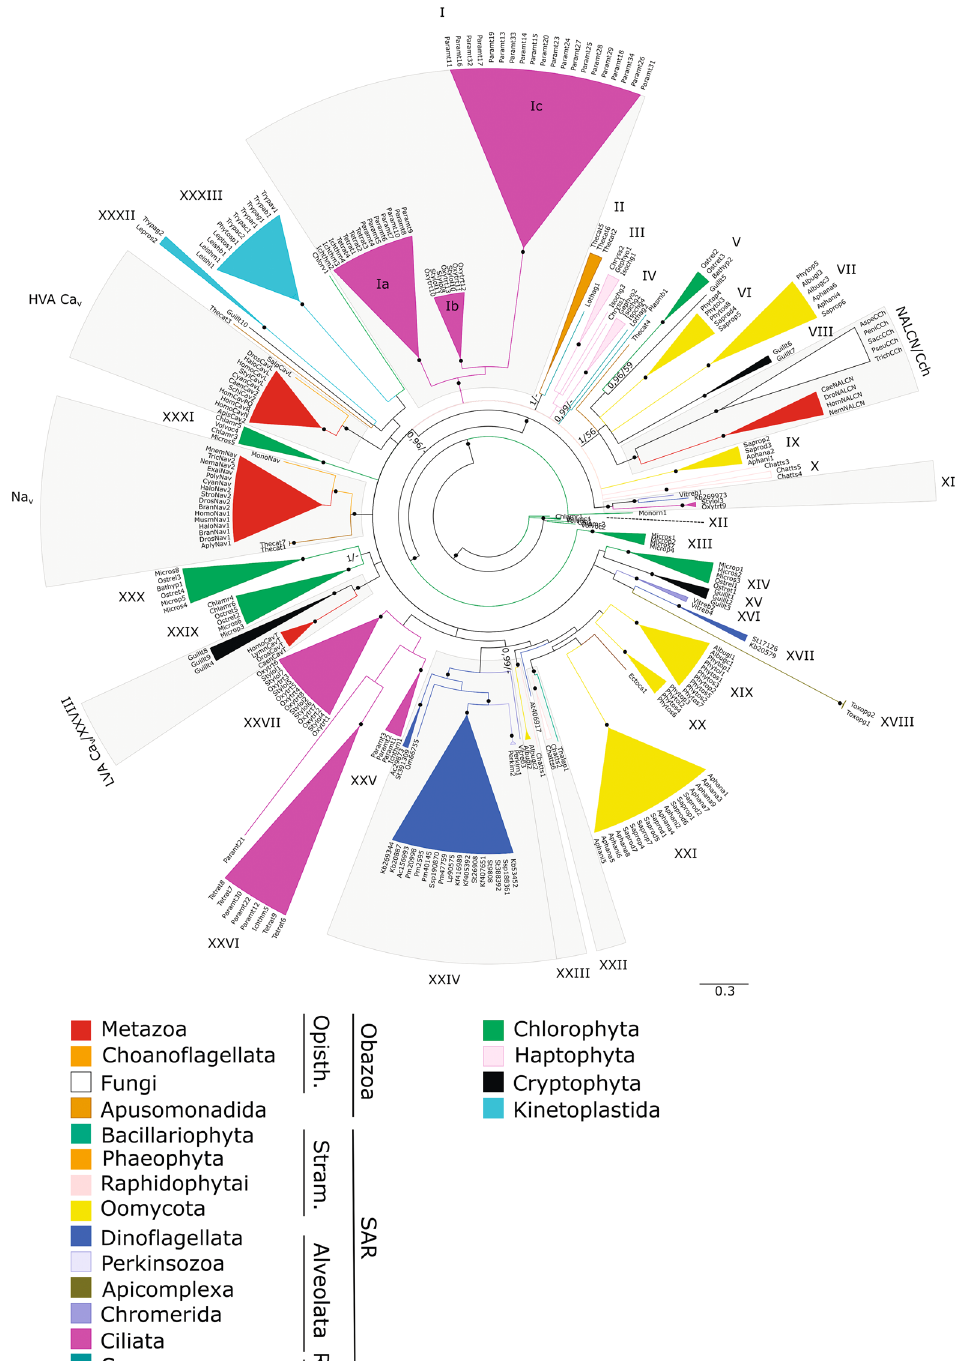
Figure 2. Collapsed phylogenetic tree of eukaryotic four-domain voltage-gated cation channels. Different colours correspond to different eukaryotic groups. Black circles indicate nodes with posterior probability/ bootstrap value ≥ 0.95/ ≥ 65 (well-supported clades (WSCs)). Every WSC, except voltage-gated sodium channels (Na v ), high-voltage activated calcium channels (HVA Ca v ), low-voltage activated calcium channels (LVA Ca v ), and sodium leak channels/calcium channels of fungi (NALCN/Cch), has been assigned a number (I–XXXIII). WSCs containing channels from more than one of 18 eukaryotic lineages are shaded. Opisth. – Opisthokonta; Stram. – Stramenopiles; Rh. –